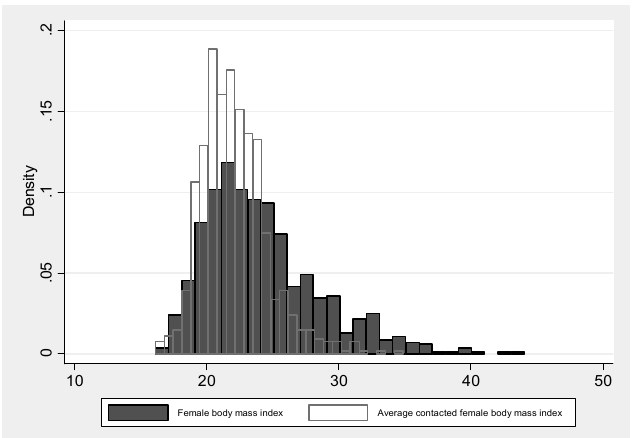
Figure 6 : Actual (dark) versus contacted (bright) female body-mass distribution (density